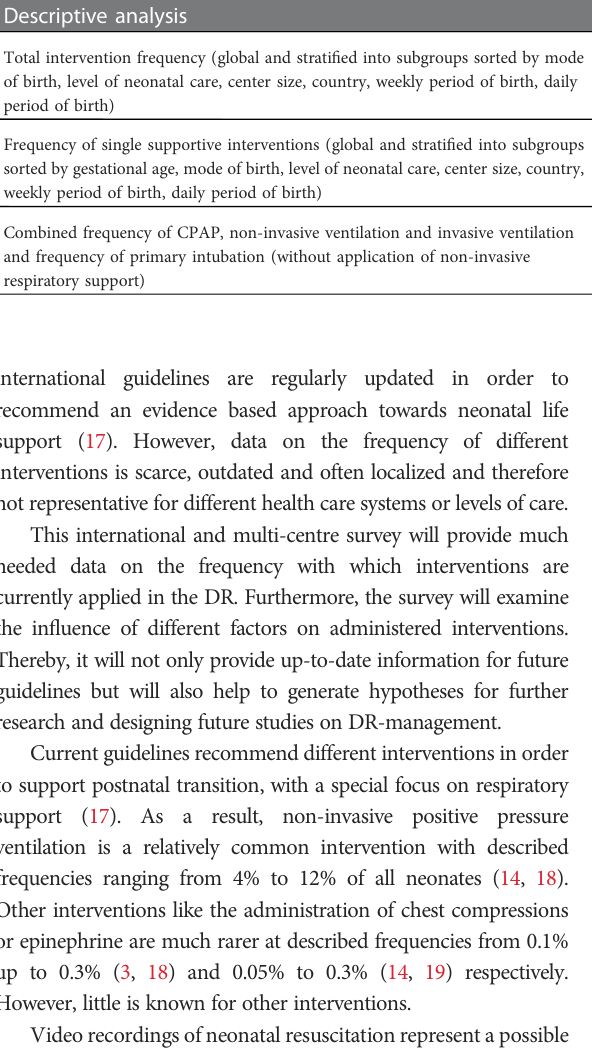
TABLE 2 List of anticipated results of descriptive and statistical analysis. Descriptive analysis Statistical